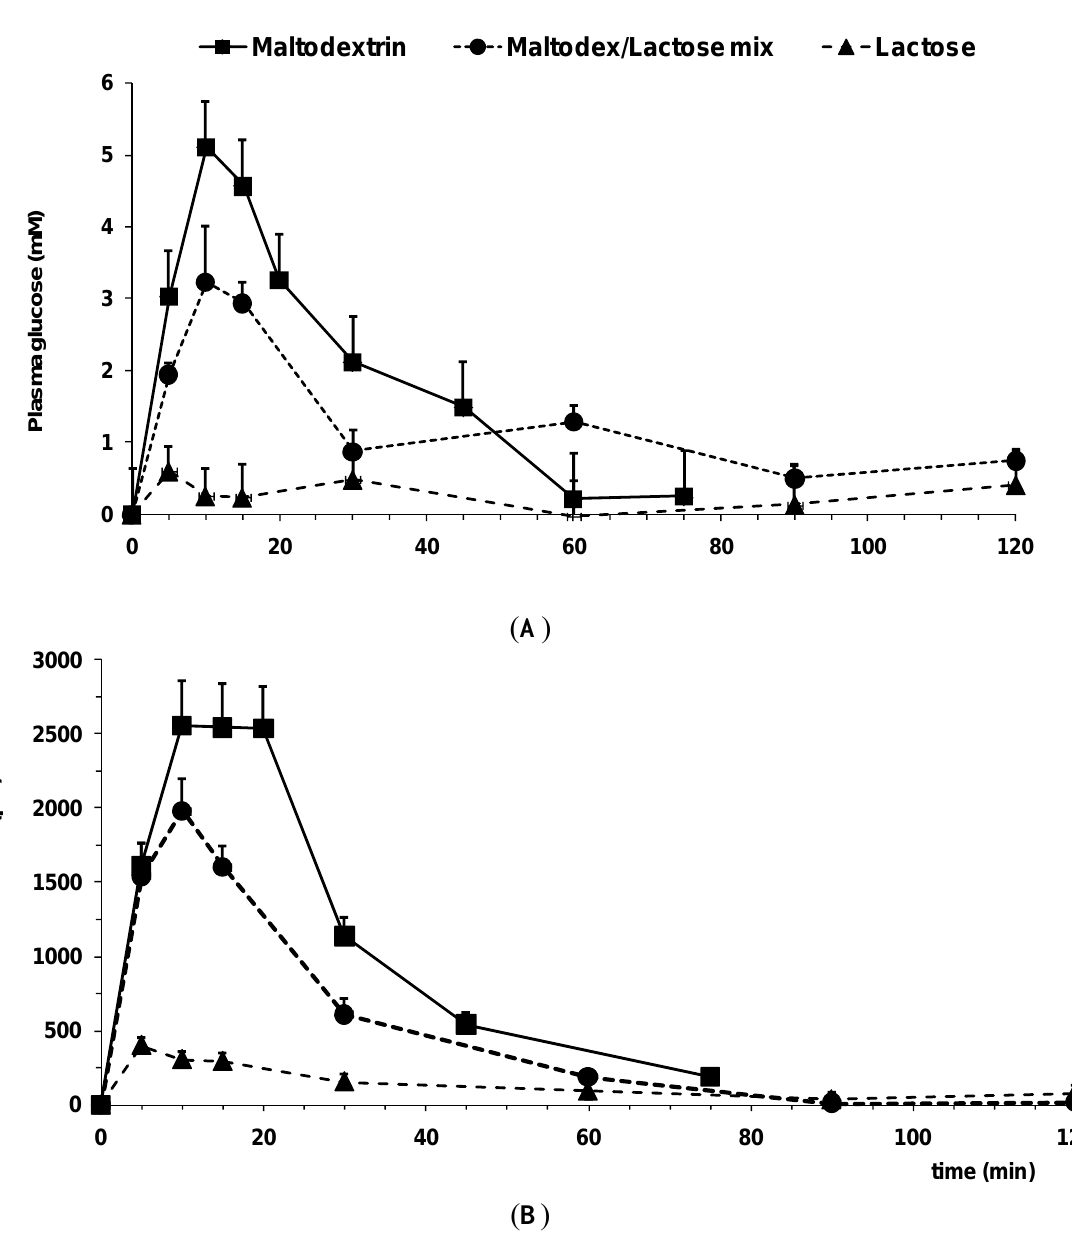
Figure 4. Incremental postprandial plasma glucose ( A ) and insulin ( B ) levels in response to administration of various aqueous carbohydrate loads ( n = 12–14). Doses instilled (per animal): maltodextrin 0.7 g; lactose 0.45 g; mix: 0.45 g lactose + 0.175 g maltodextrin. Maltodex, maltodextrin.